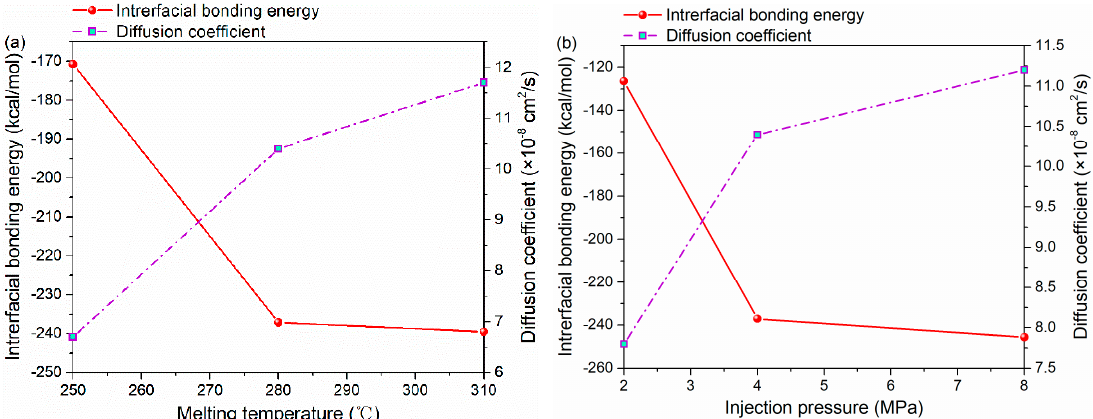
Figure 7. The interfacial bonding energy and diffusion coefficient of PA66–PP hybrid system under various processing parameters: ( a ) melting temperatures and ( b ) injection pressure.